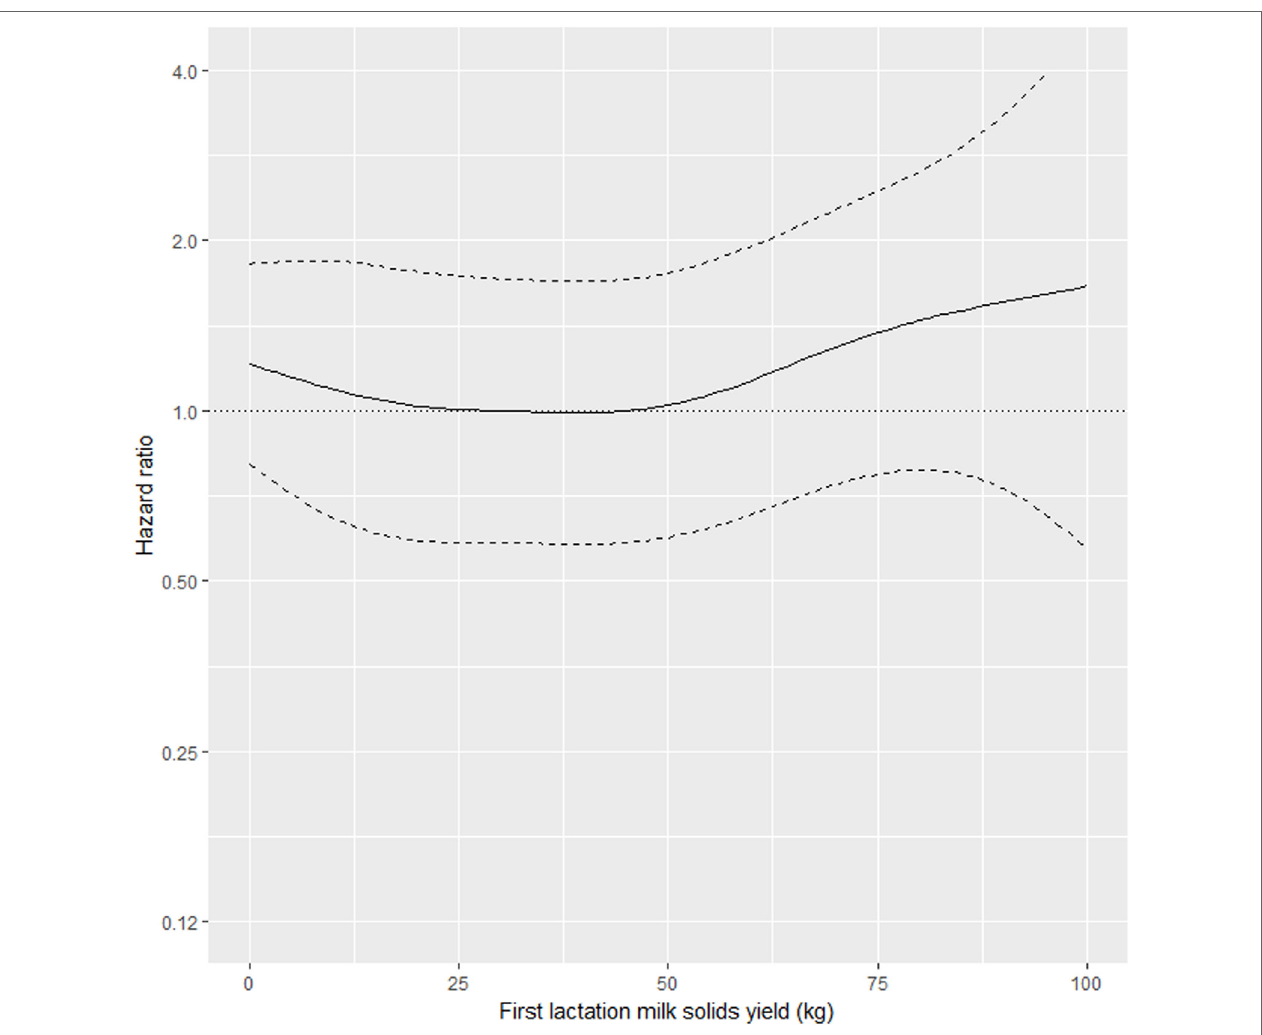
FigUre 3 | Risk factors for culling, sales and deaths in New Zealand dairy goat herds, 2000–2009. Line plot showing, for the interval greater than 730 days from the date of second kidding, the hazard ratio for removal as a function of MSL1 (based on the model presented in Table 2 ). The dashed lines represent 95% confidence intervals around the point estimates of the hazard ratio. In the above plot, the reference category was a doe producing 30 kg milk solids in the first lactation. A doe producing 80 kg milk solids in the first lactation had 1.44 (95% CI 0.79–2.65) times the daily hazard of removal compared with a doe that produced 30 kg milk solids in the first